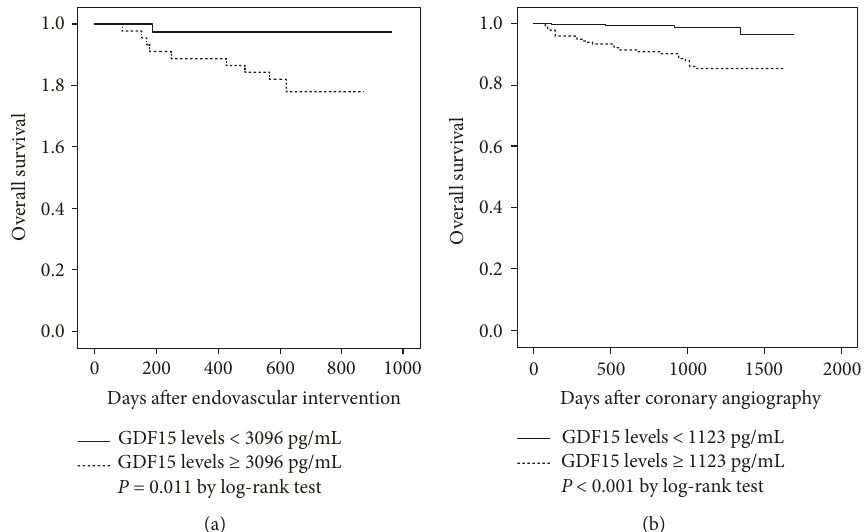
Figure 2: (a) Kaplan-Meier survival curves for patients with peripheral artery disease. Event-free survival curves for all-cause mortality at a mean follow-up of 21 months were plotted using the Kaplan-Meier method, and P values were calculated using the log-rank test. (b) Kaplan- Meier survival curves for patients with coronary artery disease. Event-free survival curves for all-cause mortality at a mean follow-up of 33 months were plotted using the Kaplan-Meier method, and P values were calculated using the log-rank test.